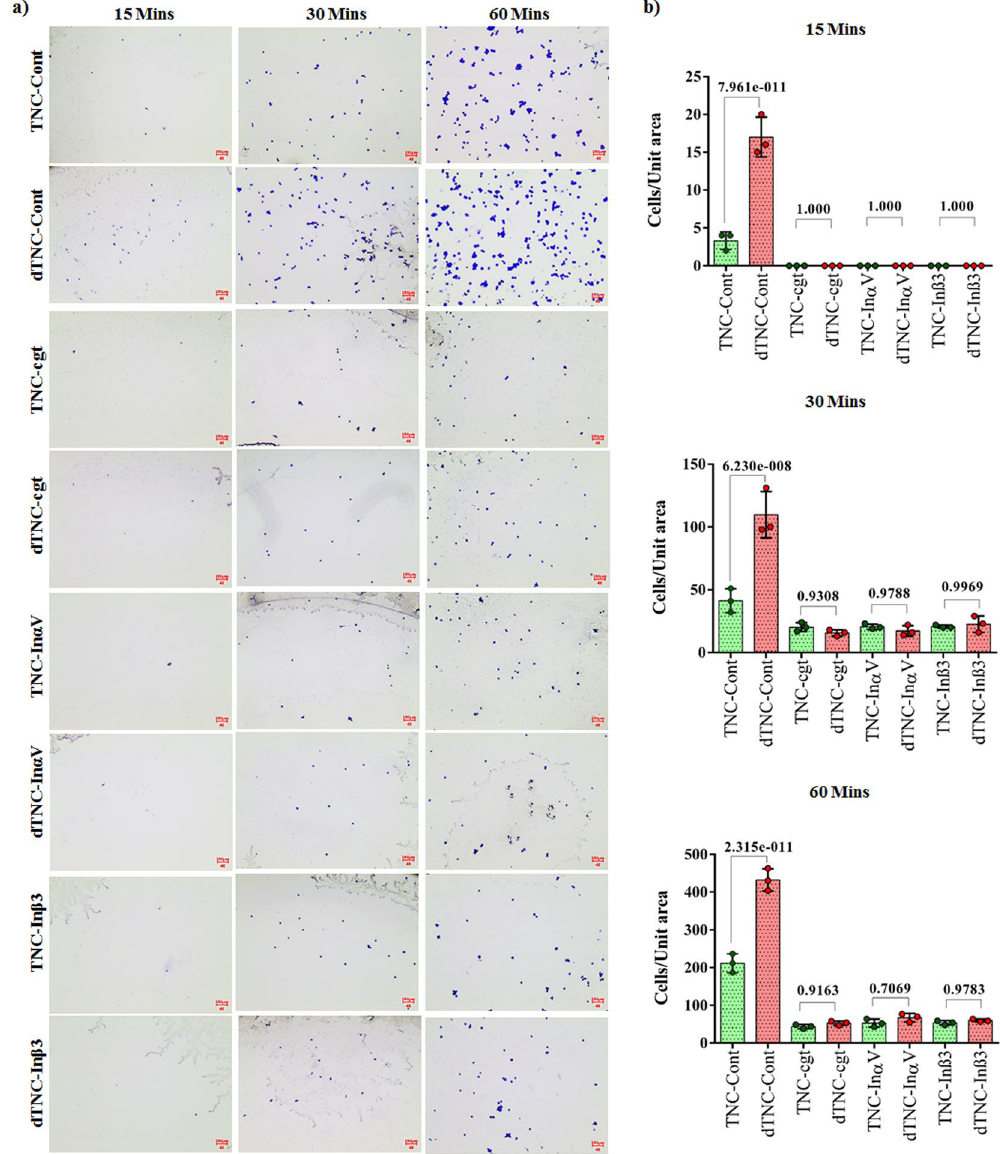
Figure 4. Microscopy images of differentiated U937 monocytic cell adhesion to culture plates coated with ECM proteins tenascin C (TNC) or deamidated tenascin C (dTNC) in different experimental conditions ( a ). Scale bar indicates 100 µ m. Quantitation of cell adhesion to ECM proteins Tenascin C and deamidated Tenascin C under different experimental conditions. Statistics were calculated from experimental triplicates. Tenascin C (TNC); Deamidated Tenascin C (dTNC). Differentiated U937 cells (Cont) were treated or not with Cilengitide (cgt) or monoclonal antibodies against integrin α v (In α v ) or integrin β 3 (In β 3